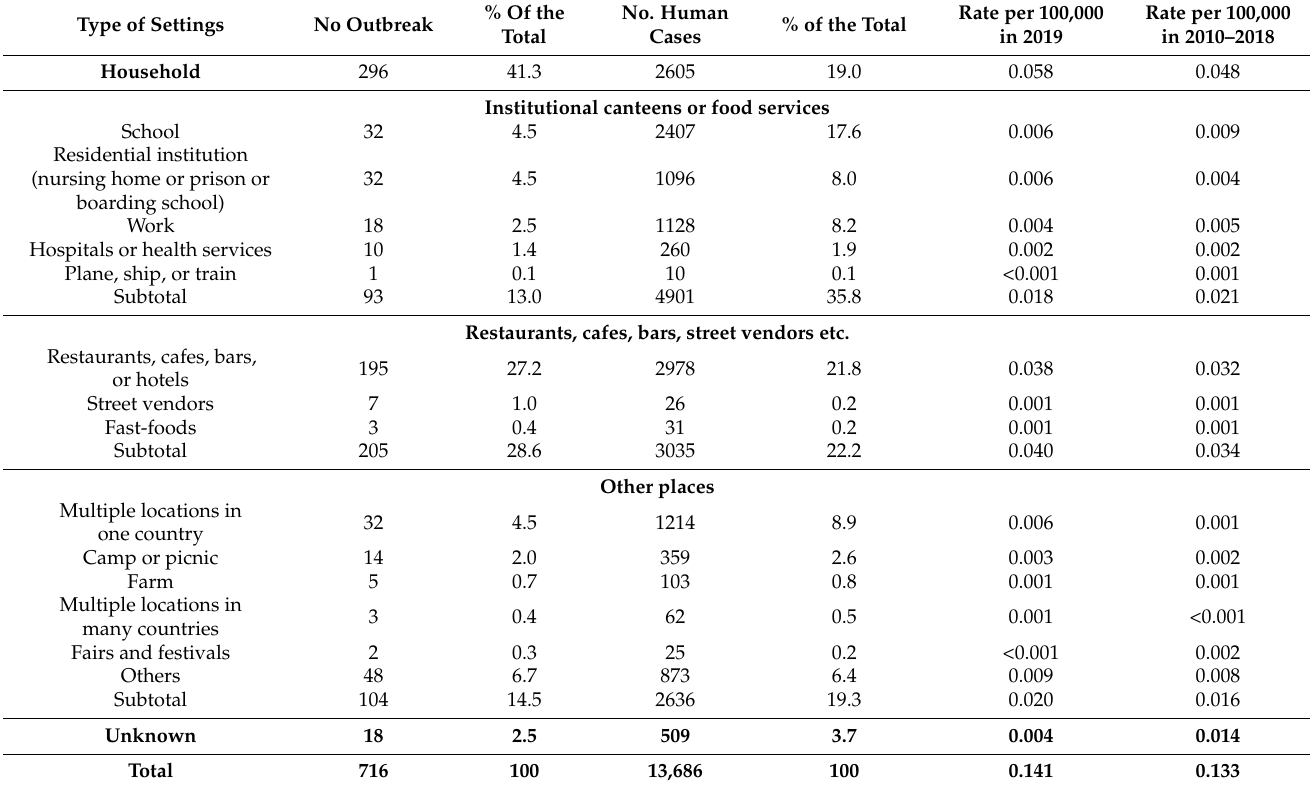
Table 3. FBD outbreaks by exposure place in the European Union in